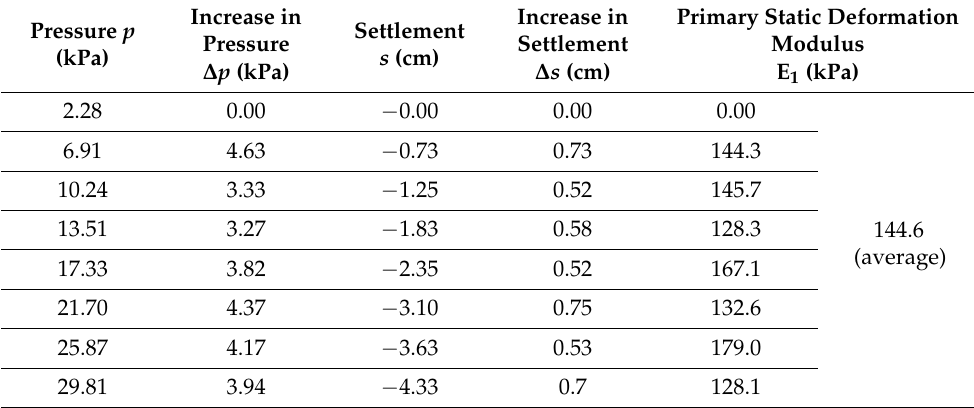
Table 3. Primary static deformation